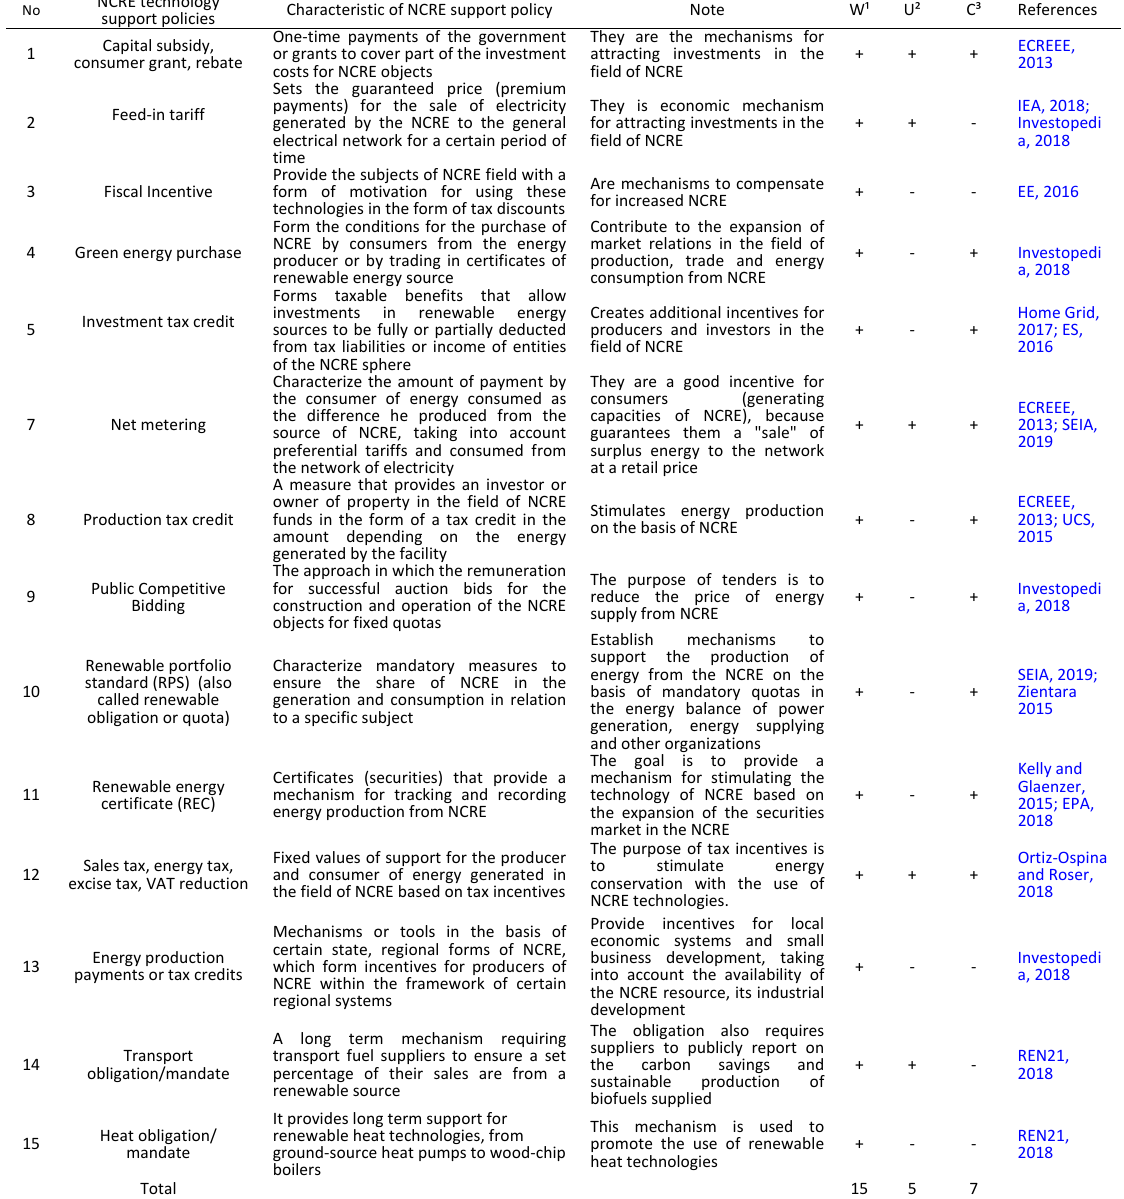
Table 4: Renewable energy support policies used in world practice